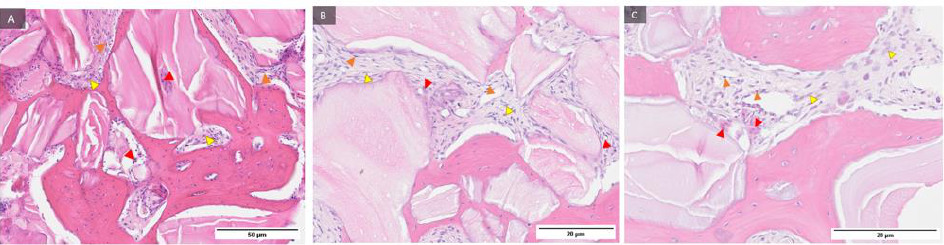
Figure 3. Examples of preparations of the control group ( A – C ) with labelled fibroblasts (yellow filled triangle), fibrocytes (orange filled triangle), and cells of the monocyte–macrophage system (red filled triangle). Magnification: 100, 200, 400×.